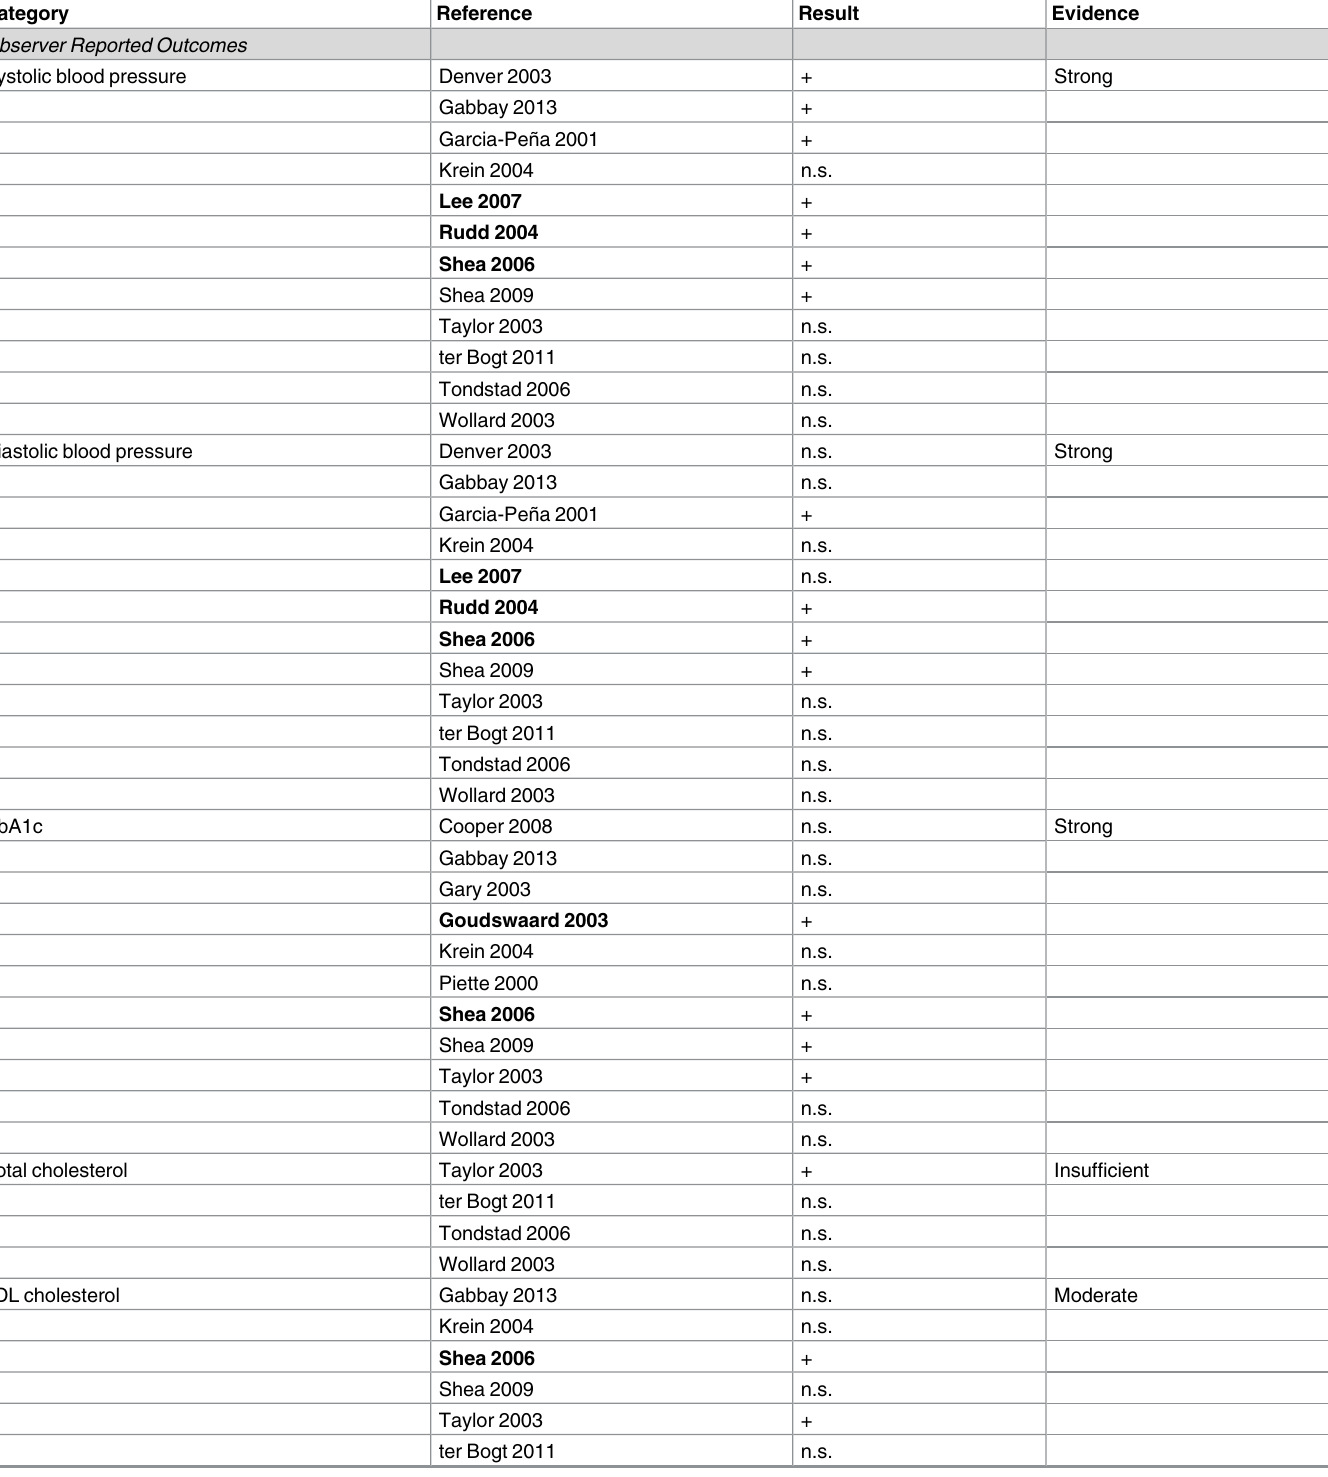
Table 3. Findings of the impact of nurse led-self management interventions on Observer Related Outcomes (OROs) and Patient Related Out- comes (PROs).